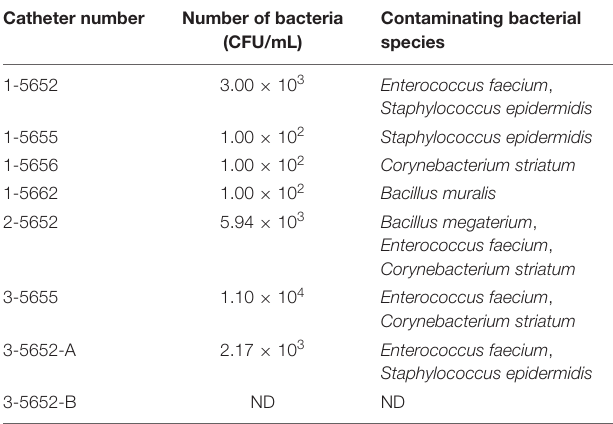
TABLE 1 | Identification of contaminated bacterial species isolated from the catheters.